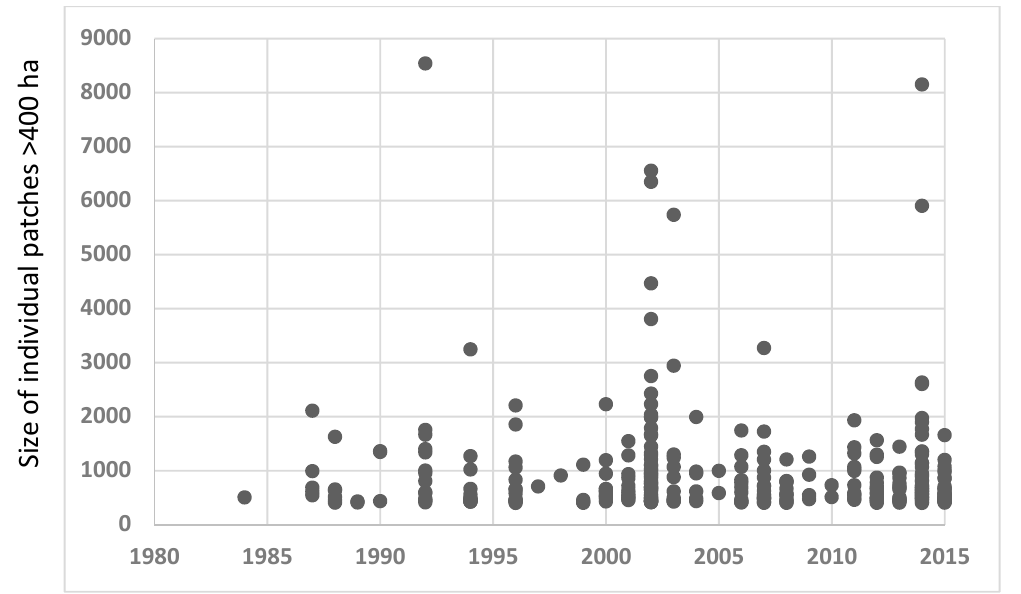
Figure 2. Annual area of large (>400 ha) CESF patches in the four time periods (see Table 1 and 2 for time periods).